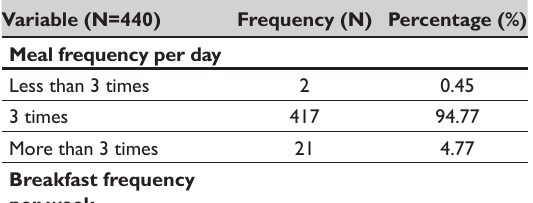
Table 1: Meal frequency and food consumption pattern of the school-aged children